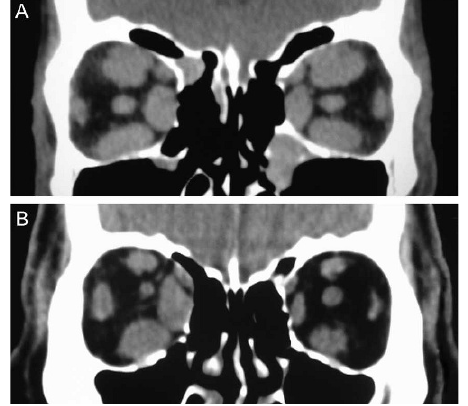
Figure 2 - Axial CT scans from two patients with Graves’ orbitopathy. A) Patient with prominent enlargement of the medial and lateral recti muscles. B) Patient with severe proptosis of both orbits with clear fat tissue augmentation and no extraocular muscle